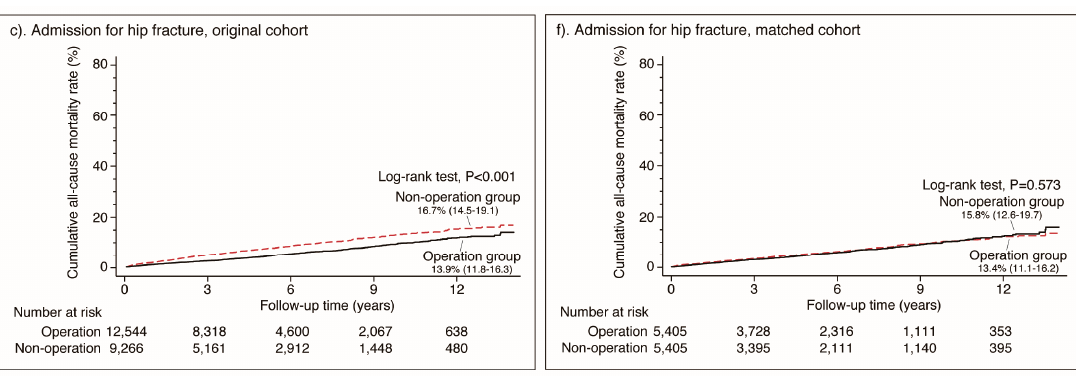
Figure 2. Cumulative incidences of all-cause mortality ( a , d ), respiratory problems ( b , e ), and hip fractures ( c , f ) during the 14 years of follow-up of both the non-operation and operation groups.